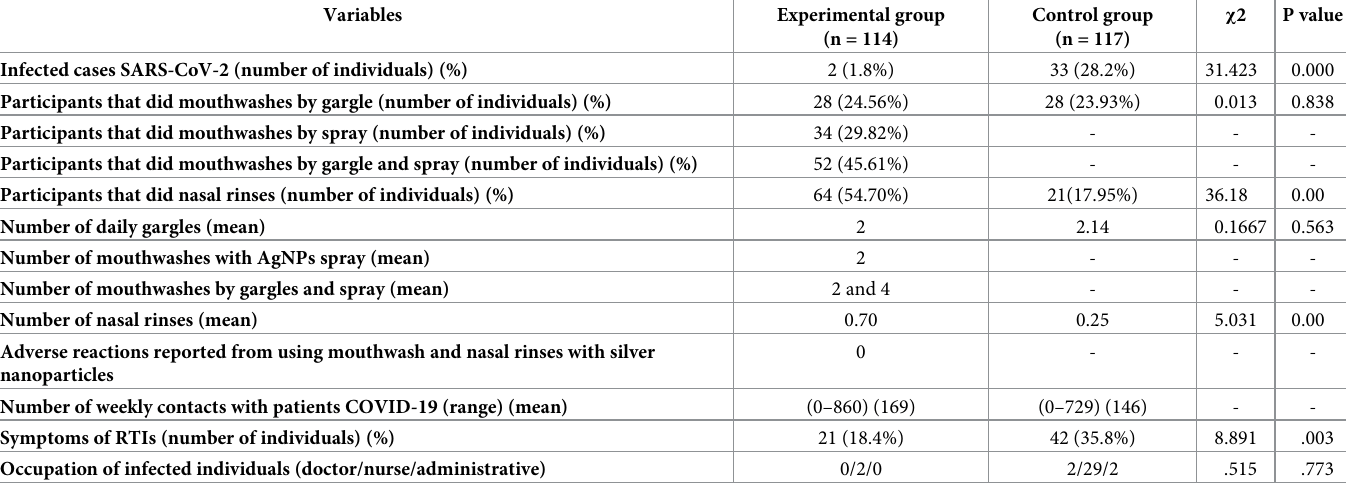
Table 2. Prevention of SARS-CoV-2 infection in health workers.